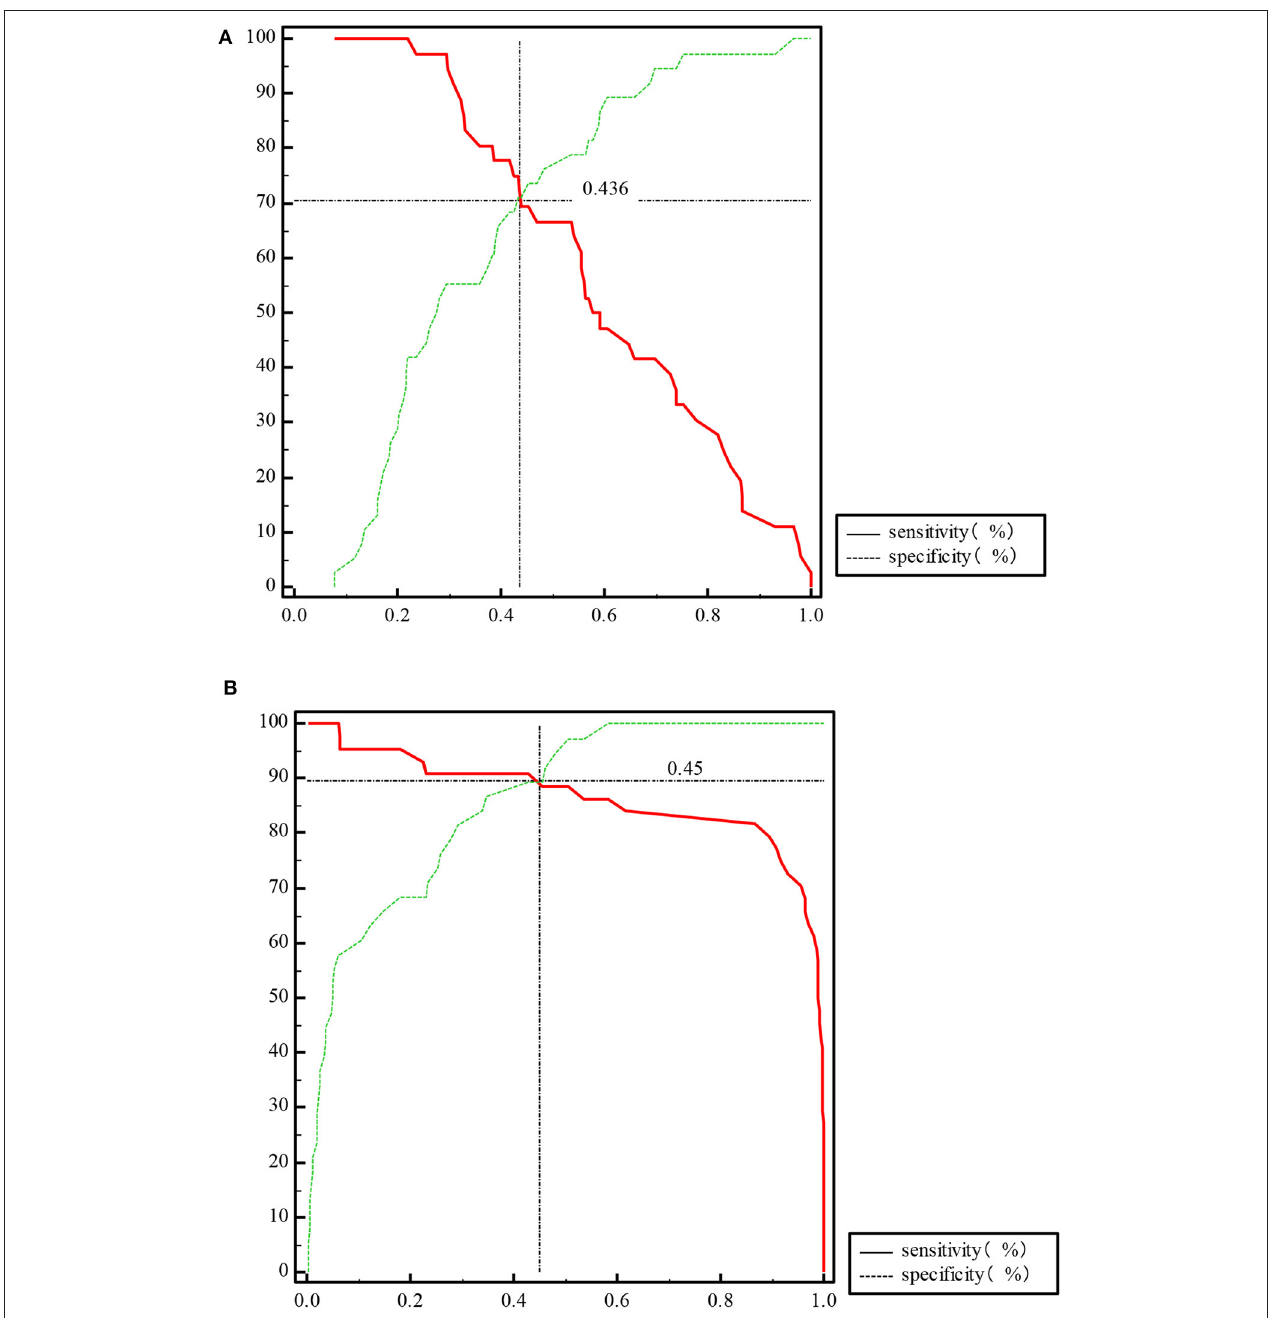
FIGURE 4 | Plot vs. criterion values of propensity for IFN- β and PLT combined detection at acute phase of KD (A) and subacute phase of KD (B) .